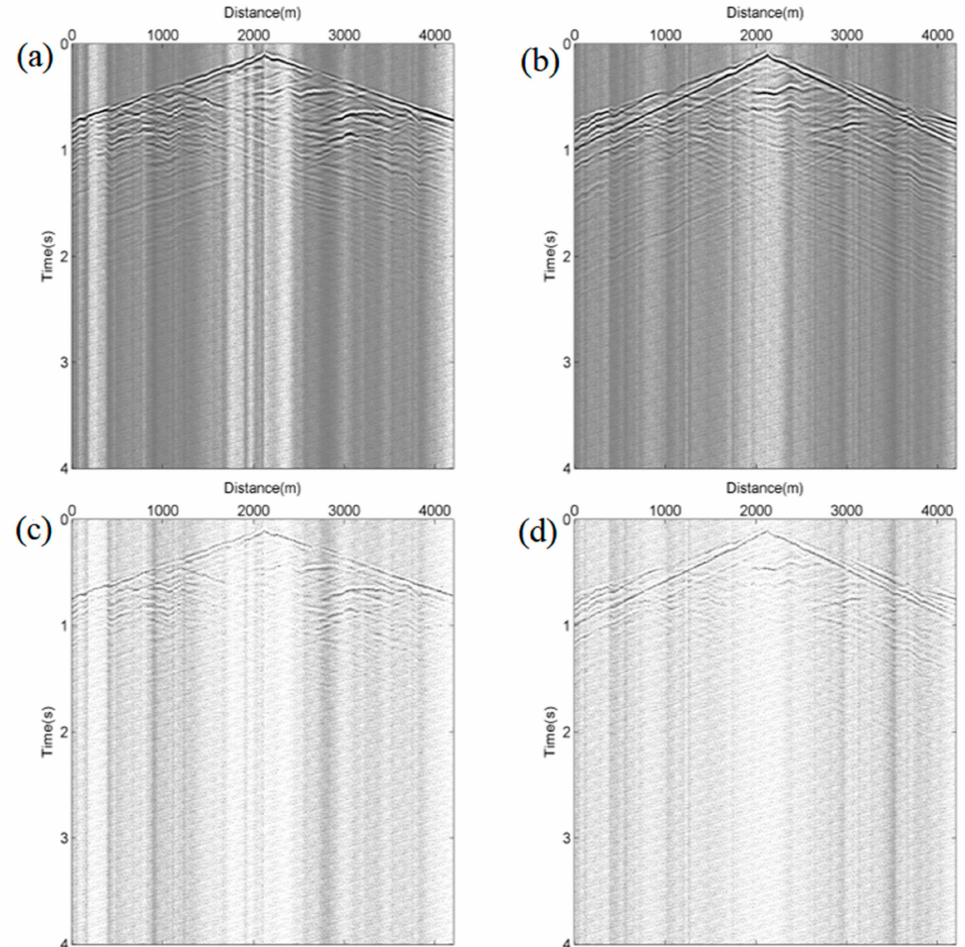
Figure 17. The noisy common-shot gathers for modified-topography Canadian Foothills elastic models with different SNR values. The left panels are the horizontal component common-shot gathers, and the right panels are the vertical component common-shot gathers. Panels ( a , b ) are the common-shot gathers with SNR 1 dB, and panels ( c , d ) are the common-shot gathers with SNR 4 dB. The modified Canadian Foothills elastic model with high-quality images further demonstrates that our proposed ERTM method could efficiently remove the influence of complex topography on the ERTM PP images and PS